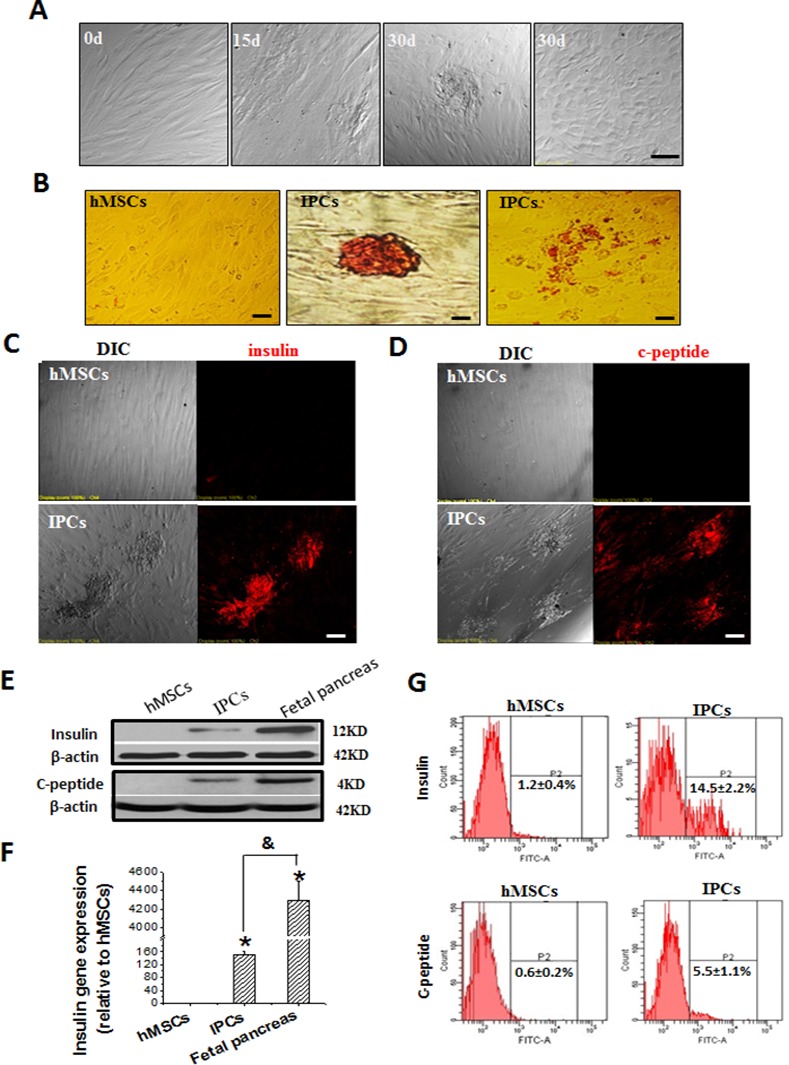
HMSCs differentiated into insulin-producing cells (IPCs).hMSCs at passage 5 (P5) were induced to differentiate into IPCs by a 30-day protocol. Briefly, hMSCs were induced in high glucose (23.3 mmol/L)-DMEM with 5% FBS for 15 days (referred to as HD-hMSCs); then cultured in L-DMEM medium containing 5% FBS and 20 μmol/L nicotinamide for 7 days; at last, Exendix-4 at 10 μmol/L was added into the medium for another 7-day incubation. After the 30-day induction, cells were fixed or harvested for characterization. A: During the 15 days of induction, small cell aggregates were formed, and during continued culture, more islet-like clusters and round epithelial-like cells appeared. B: The islet-like clusters (middle) and round epithelial-like cells (right) of differentiated hMSCs were positive for Dithizone staining (red color), while the undifferentiated hMSCs were negative. C and D: Immunofluorescence staining showed that islet-like clusters expressed both insulin (C) and c-peptide (D). E: Western blot assay further confirmed the expression of insulin and c-peptide proteins in the induced cells, the fetal pancreas from 6-month-old aborted fetus was used as control. F: The insulin gene expression was evaluated by real-time PCR in hMSCs and IPCs, for which the fetal pancreas was used as positive control. G: Flow cytometry analysis demonstrated that there was 14.5 ± 2.2% of insulin-positive cells and 5.5 ± 1.1% of c-peptide positive cells in the induced cells from P5 hMSCs. All in vitro data were obtained from at least 3 independent experiments. Data are presented as means ± SD (* P<0.05 compared to hMSCs; & P<0.05 compared between hMSCs and fetal pancreas). Scale bars: 50 μm for A-D.